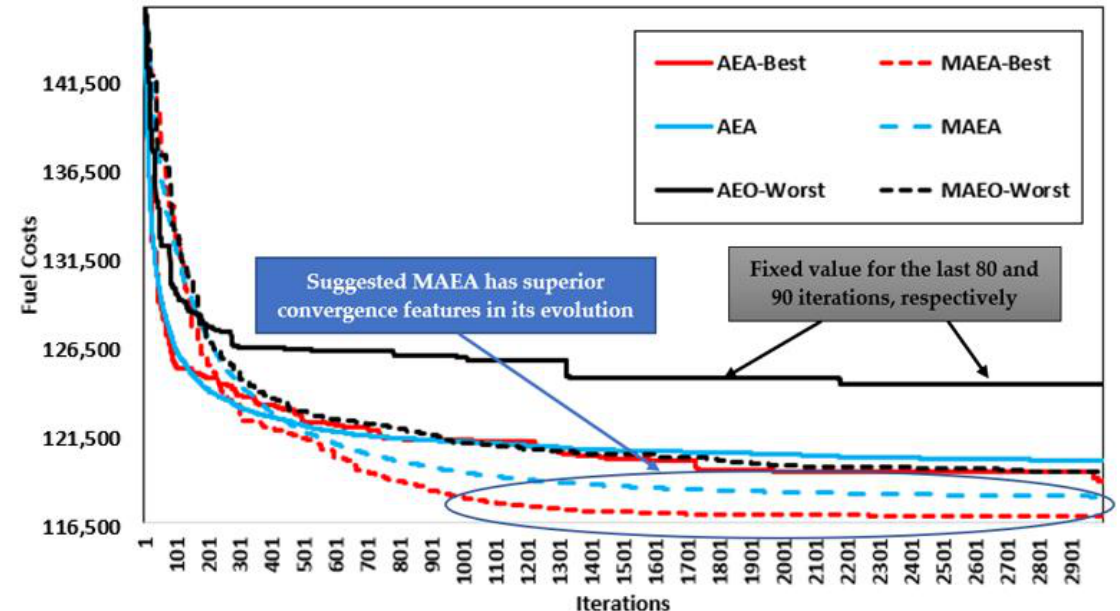
Figure 11. Convergence rates of the proposed MAEA and the basic AEA of Case 3.